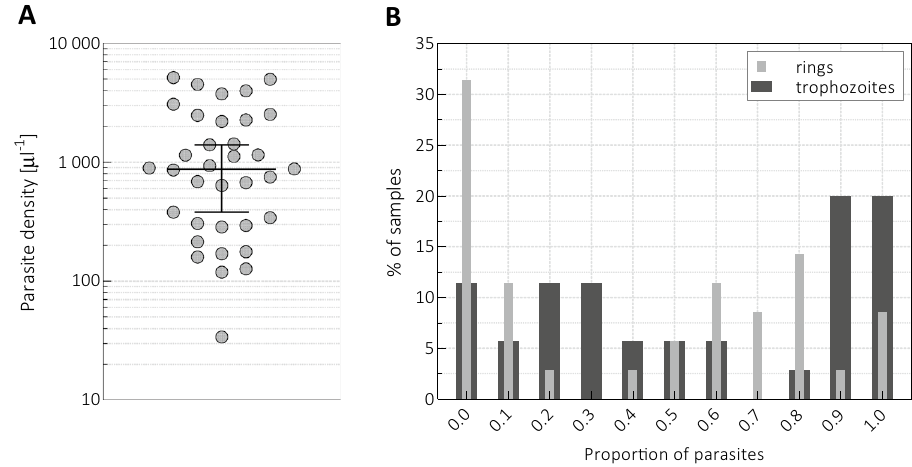
Figure 1. ( A ) The parasite density values of the P. vivax -infected samples (n = 35) with their median and the 95% confidence interval (95%-CI) of the median. ( B ) The percentage of samples containing the indicated proportion of rings (light grey columns) and trophozoites (dark grey columns), i.e., histograms of the incidence rate of rings and